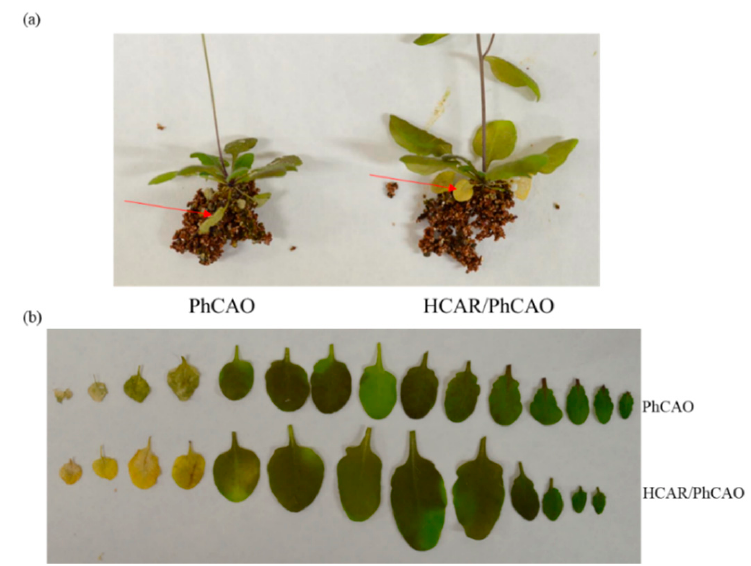
Figure 3. Overexpressing HCAR alleviates the non-PCD (non-programmed cell death) symptoms in PhCAO during natural senescence. Plants were grown under long-day growth conditions for 7 weeks, and ( a ) the whole plants and ( b ) their all detached leaves were imaged with a digital camera. Red arrows indicate the senescence symptoms of No. 3 or 4 leaves of plants.